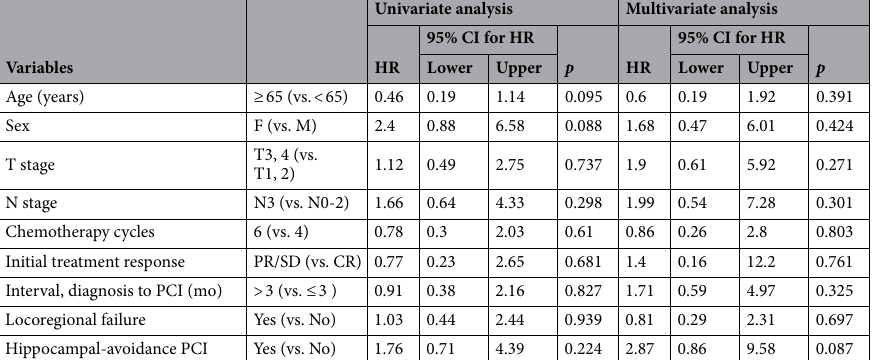
Table 2. Prognostic factors for intracranial failure. RT radiotherapy, 3D-CRT 3-dimensional conformal radiotherapy, IMRT intensity-modulated radiotherapy, CR complete response, PR partial response, SD stable disease, PCI prophylactic cranial irradiation, HR hazard ratio, mo